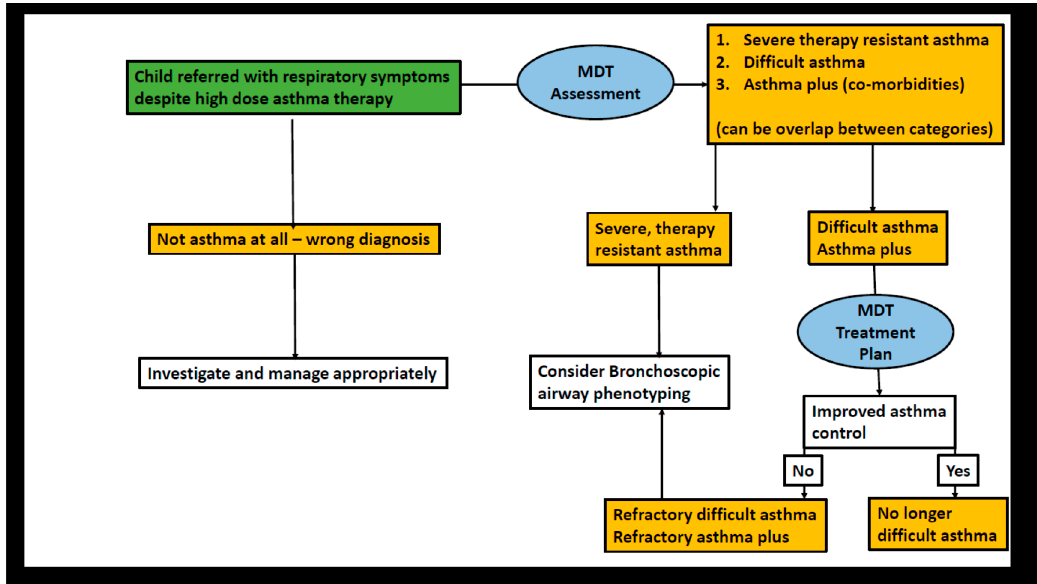
Figure 1. Flow chart for assessment of the child referred for assessment of asthma symptoms not responding to treatment. Abbreviation: MDT, multidisciplinary treatment.